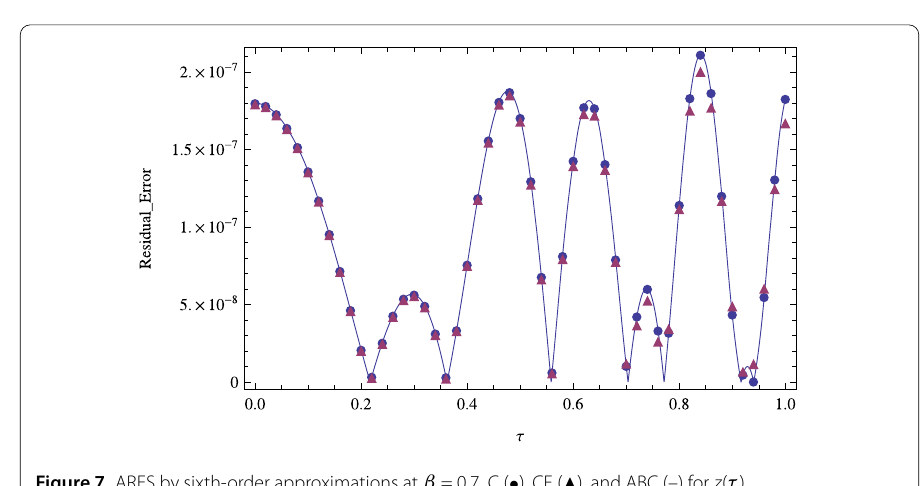
Figure 7 ARES by sixth-order approximations at β = 0.7, C ( • ), CF ( (cid:2) ), and ABC (–) for z ( τ )